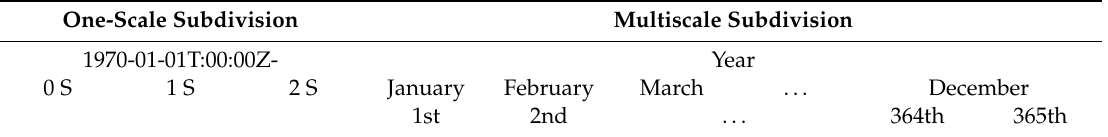
Table 1. The di ff erences between one-scale and multiscale temporal